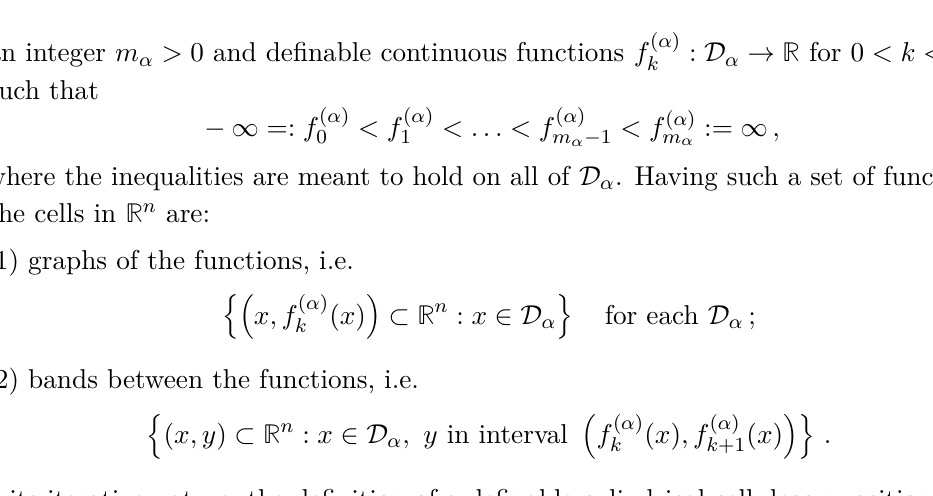
Figure 4 . A definable cylindrical cell decomposition of R